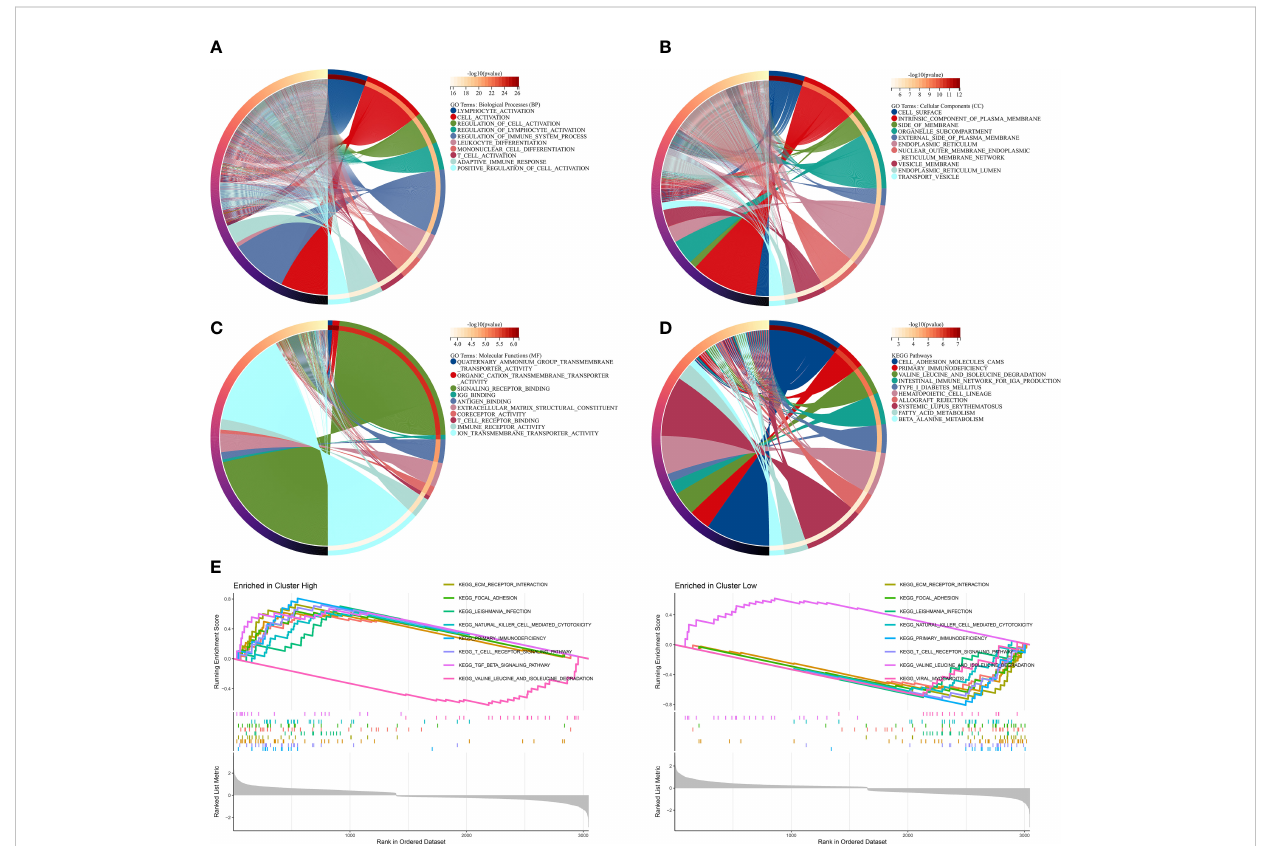
FIGURE 7 Functional enrichment analysis based on MRMGPS. (A – C) GO analysis based on MRMGPS-related DEGs between high- and low-risk groups. (D) KEGG analysis based on MRMGPS-related DEGs between high- and low-risk groups. (E) GSEA analysis based on MRMGPS-related DEGs between high- and low-risk